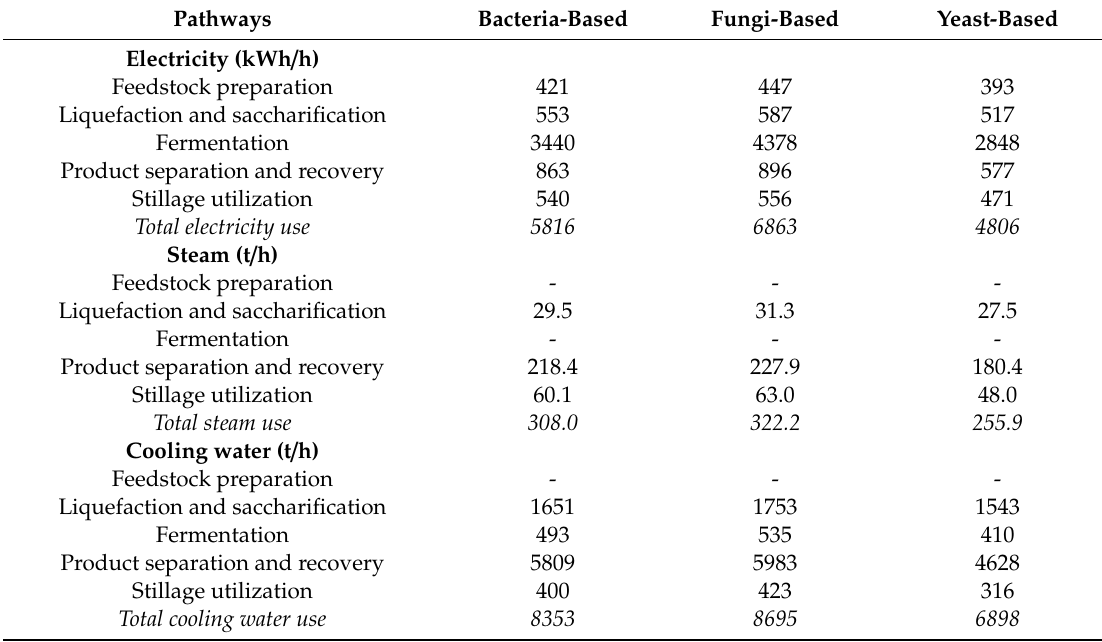
Table 3. Utilities requirements for di ff erent corn-grain-to-lactic-acid production pathways in a 100,000 t / y lactic acid production facility (based on average values reported in Table 1).